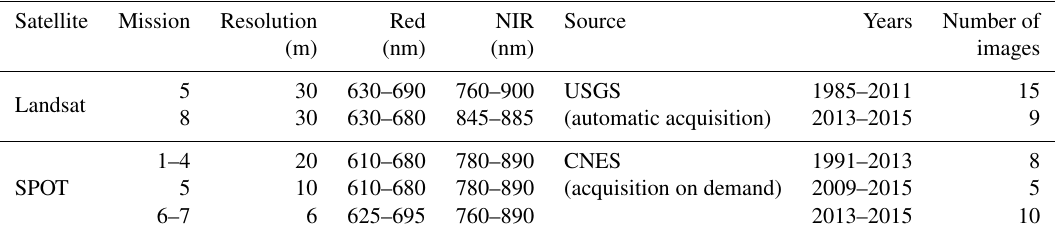
Table 1. Characteristics of the satellites, missions and sensors used to build the RS time series. The number of images corresponds to the contribution of each satellite to the dataset after a quality-control data